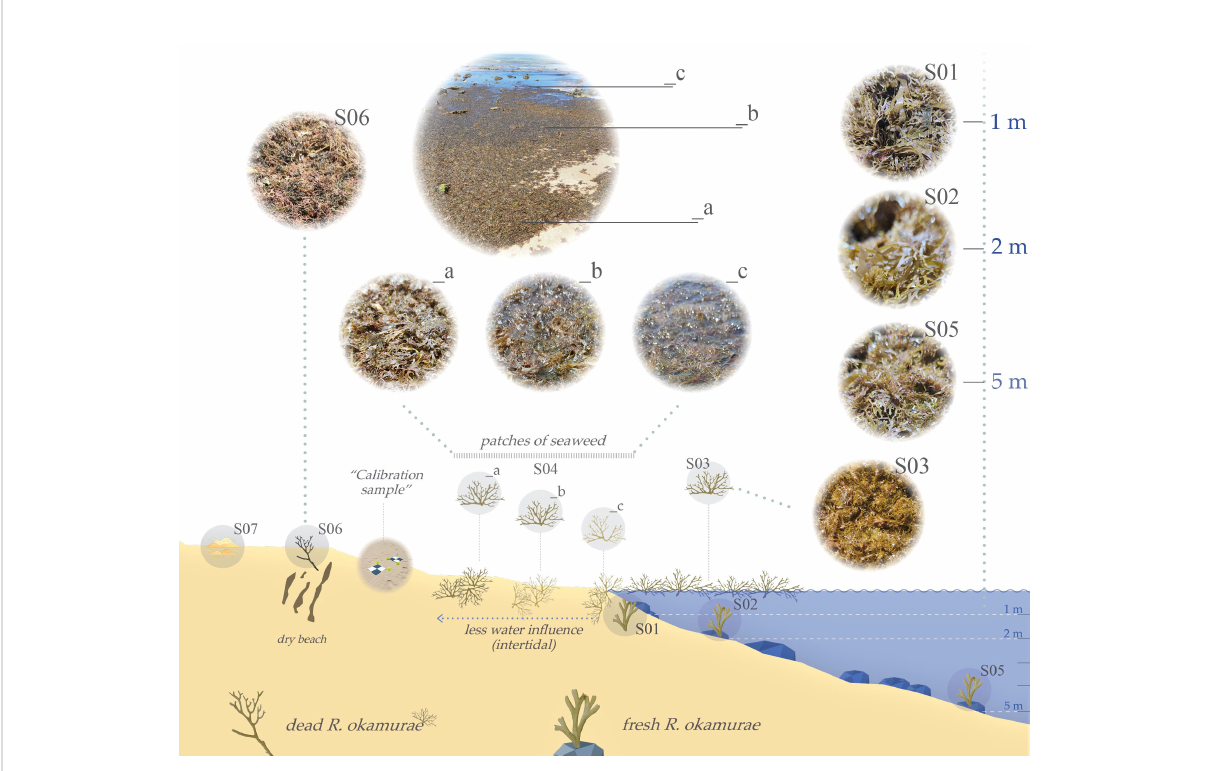
FIGURE 4 Diagramme of collected samples measured with the hyperspectral fi eld radiometer on Bolonia beach (Tarifa, Spain) on 1 st of July 2021. Fresh R. okamurae was collected between 1 and 5 m depth; dead R. okamurae was collected in different stages across the beach pro fi le. Codes are described in Table 1.